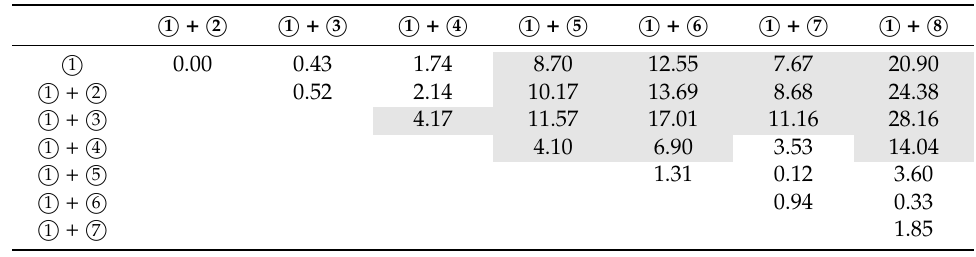
Table 8. The chi-square values of McNemar tests for land cover classification in complex surface-mined landscapes using spectral bands and different types of feature sets: 1 (cid:13) : spectral bands; 2 (cid:13) : vegetation index; 3 (cid:13) : PC bands; 4 (cid:13) : the Gaussian low-pass filters; 5 (cid:13) : the mean filters; 6 (cid:13) : the standard deviation filters; 7 (cid:13) : texture measures; and 8 (cid:13) : topographic variables. The shaded ones that larger than 3.84 indicated statistically significant differences at the confidence level of 95% ( p < 0.05).